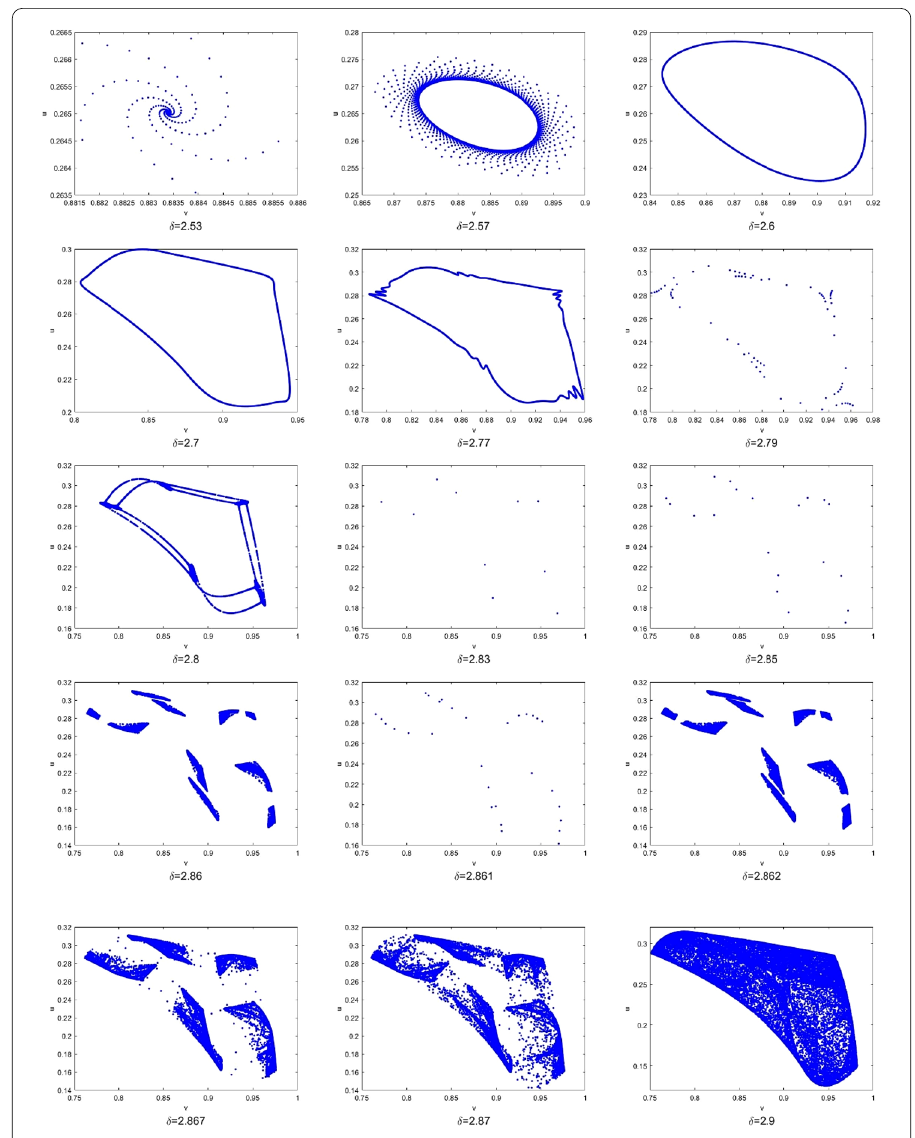
Figure 4 Phase portraits for various values of δ corresponding to Figs. 3(a), (c)